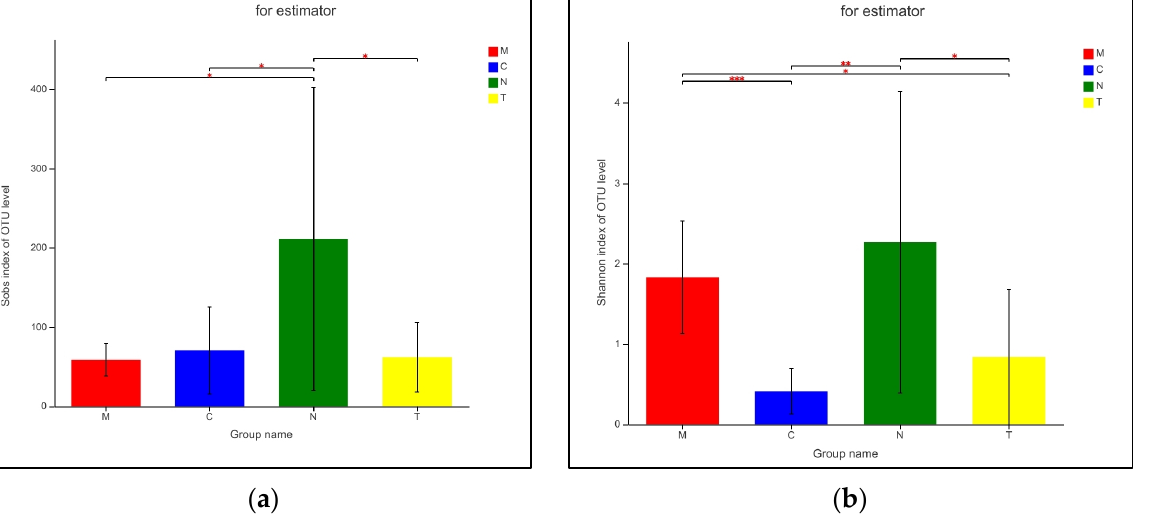
Figure 3. Vaginal microbiota richness and diversity indices associated with vaginal community state types (CSTs). ( a ) Sobs index of OTU level and ( b ) Shannon index of OTU level. Notes: * p < 0.05 , ** p < 0.01, *** p < 0.0005.